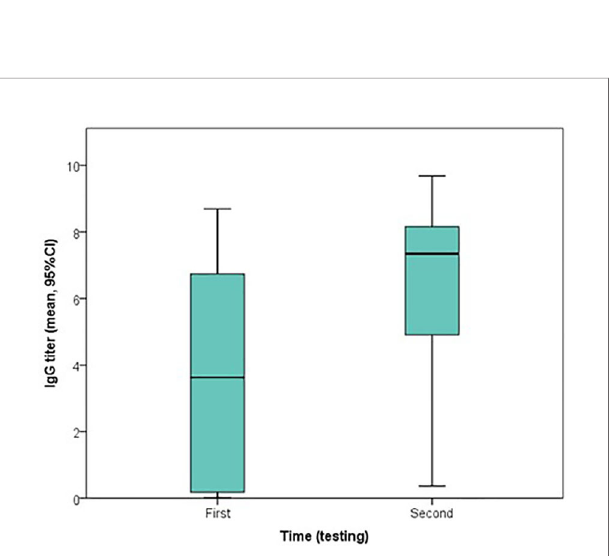
FIGURE 1 | Indices of the fi rst (A) and second (B) qualitative IgG testing, using ABBOTT method, as plotted by the time from fi rst positive rt-PCR. The red line represents the positivity threshold (index>1).